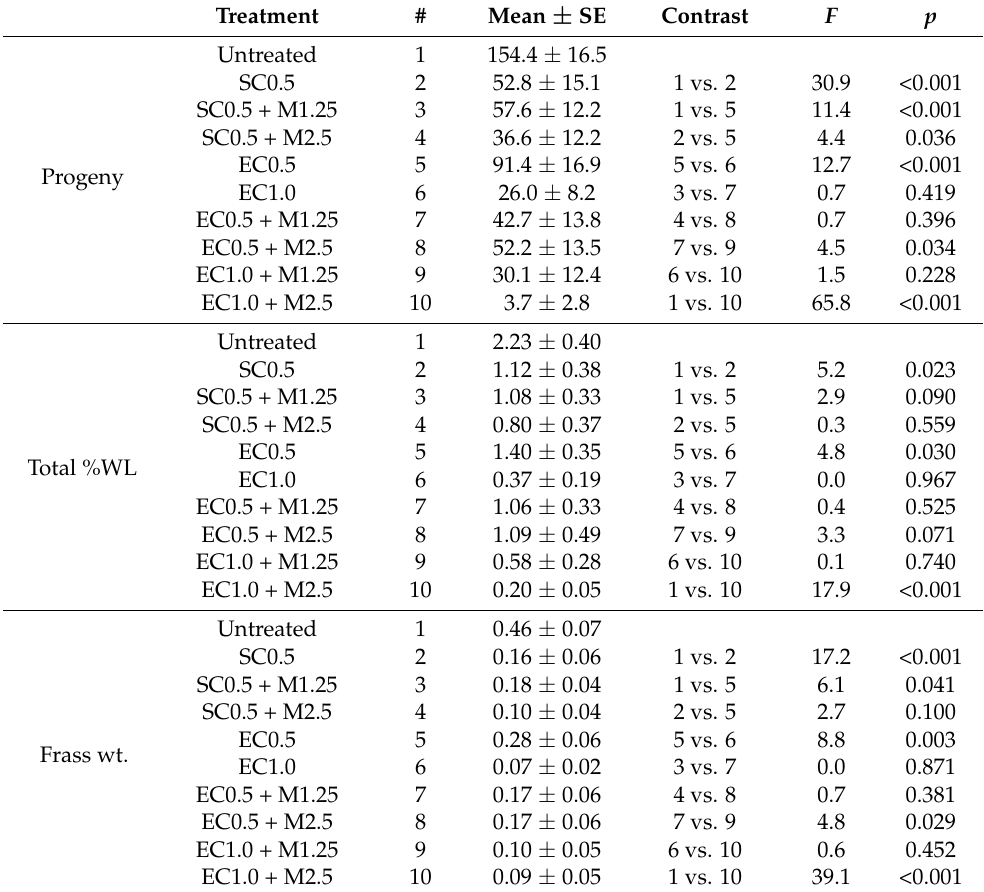
Table 2. Progeny production, total weight loss (WL in %), and feeding damage (Frass wt. in g) (means ± SE) from exposure of 10 mixed-sex parental adult S. oryzae on untreated wheat and wheat treated with the insecticide combinations in Table 1. F and P values given for selected orthogonal contrasts.